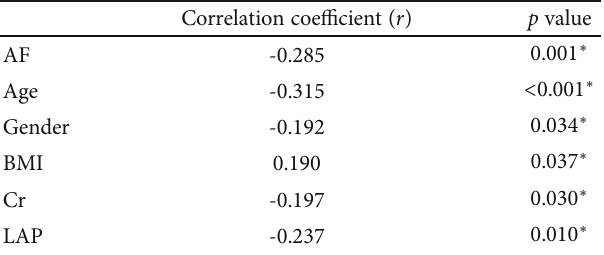
Figure 2: Relationship between plasma CTRP3 and AF course. Table 3: Relationship between CTRP3 and other